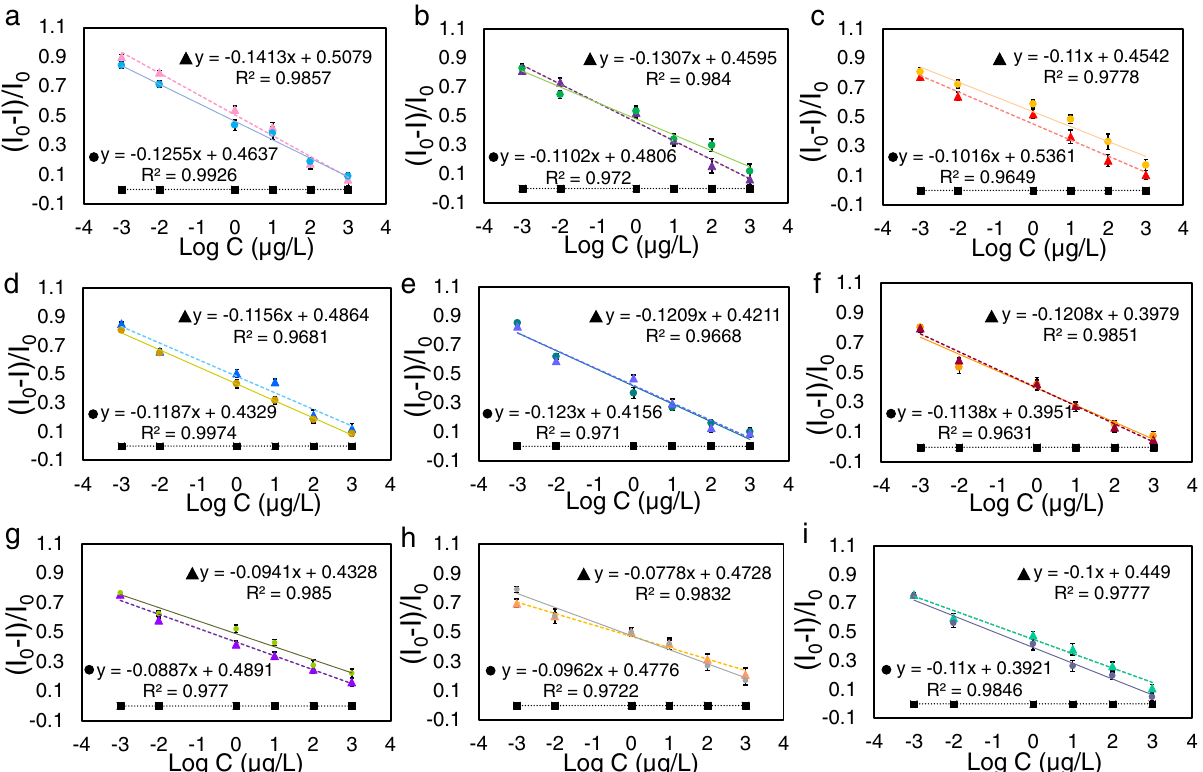
Fig. 6 | Response range of SERS-CIPs. Linear relationship between the relative SERS intensity (( I 0 − I )/ I 0 ) of SERS-CIP and the logarithm of enantiomers con- centration. I 0 and I are the SERS intensities of DTTC before and after IRM, respec- tively. a Arginine, b Asparagine, c Histidine, d Tryptophan, e Glucose, f Galactose, g Aspartic acid, h Alanyl-alanine, and i Ribose. ▲ and ● are related to D -